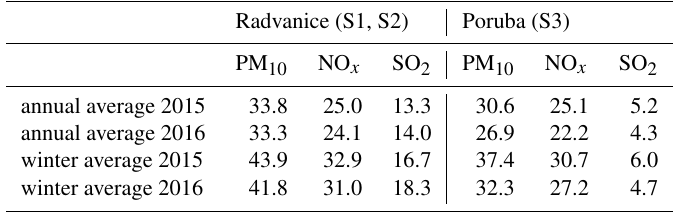
Table 2. Average concentrations of PM 10 , NO x , and SO 2 measured by the Public Health Institute of Ostrava close to Radvanice (stations S1, S2) and by the Czech Hydrometeorlogical Institute at Poruba (station S3). All values are given in µgm − 3 . Radvanice (S1,